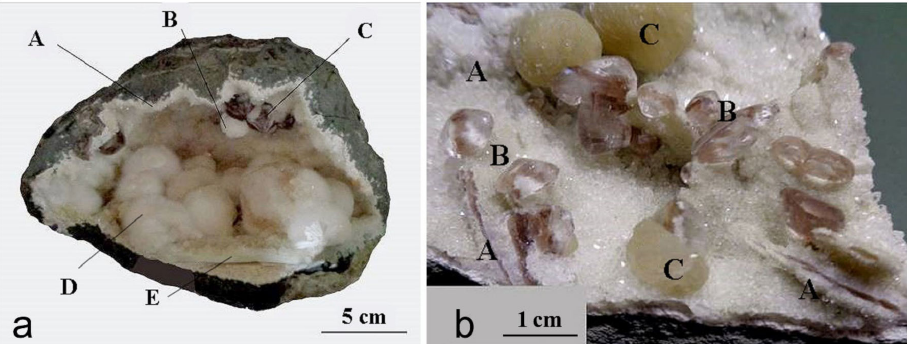
Figure 7. Photographs of hand specimens with secondary minerals and mineralized crusts. ( a ) Typical blister cavity from a pillow with slightly irregular, lenticular shape. The wall lin- ing consists of tiny quartz crystals (A). Some secondary minerals such as gyrolite (B) and calcite (C) appear all around the cavity walls, whereas okenite (D) typically tends to occur at the bottom. In addition, at the bottom, remnants of a horizontal mineralized crust (E) are visible. ( b ) Detail from a bottom part of a pillow cavity: Fragments of brownish crust (A) are encrusted by quartz and overgrown by calcite (B) and gyrolite